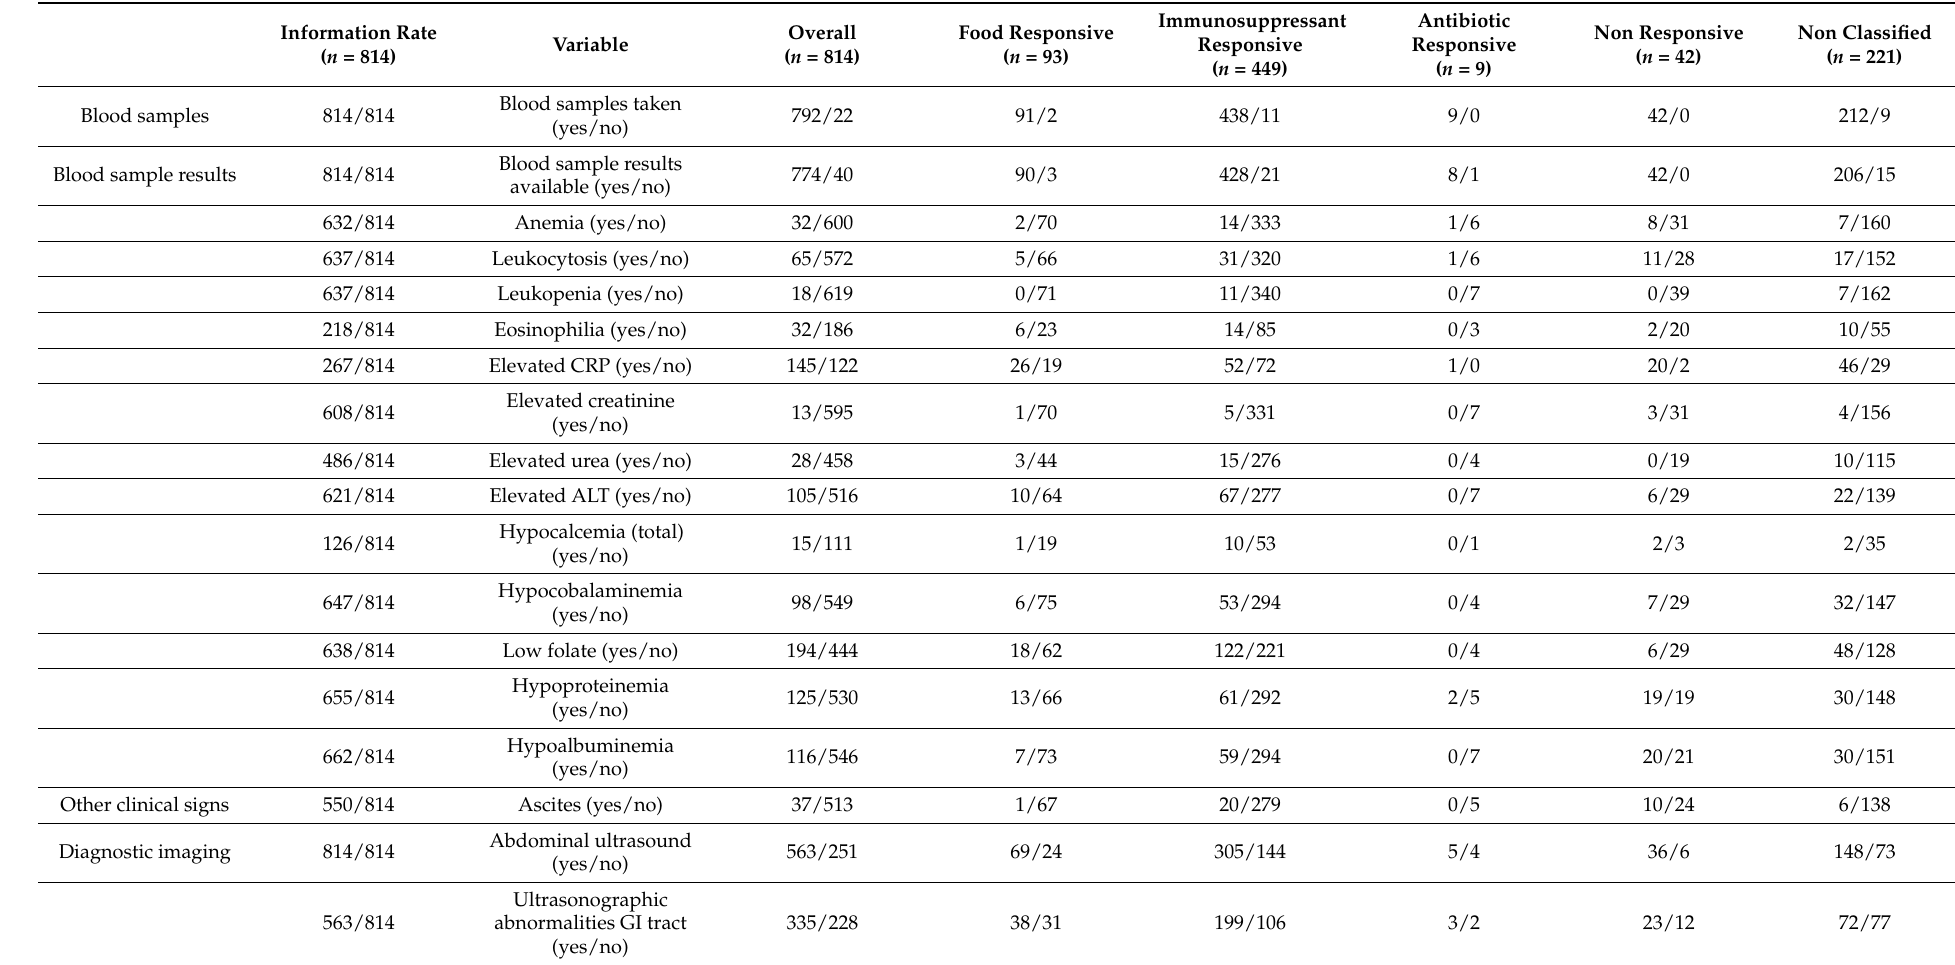
Table 2. Summary of laboratory results and ultrasonographic findings in the gastrointestinal (GI) tract by treatment outcome